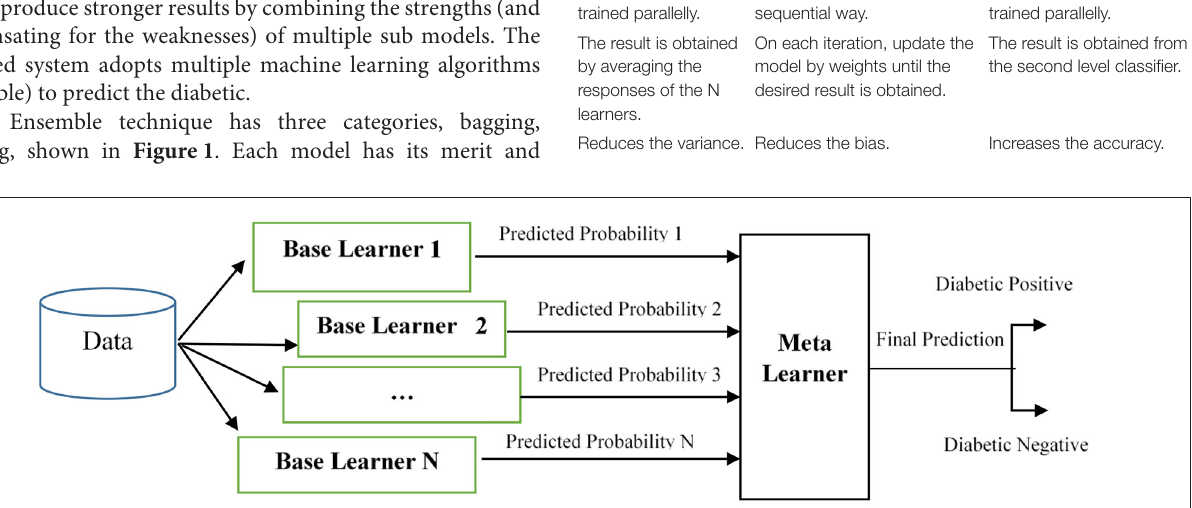
FIGURE 2 | Stacked ensemble